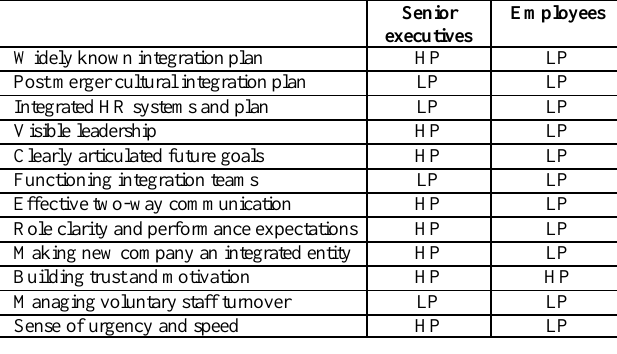
Table 1: Human resource and cultural factors in mergers and acquisitions: some key